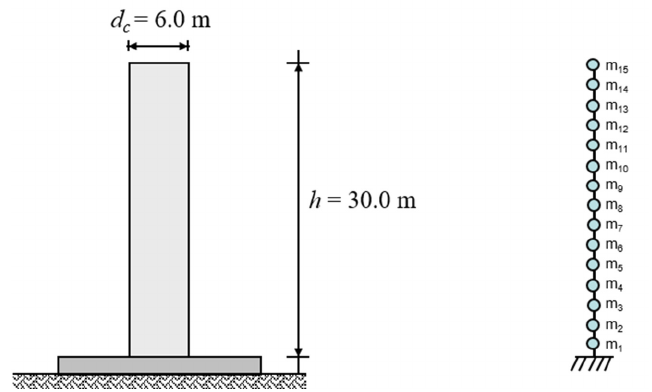
Figure 5. Slender silo and idealization as multiple mass oscillator.